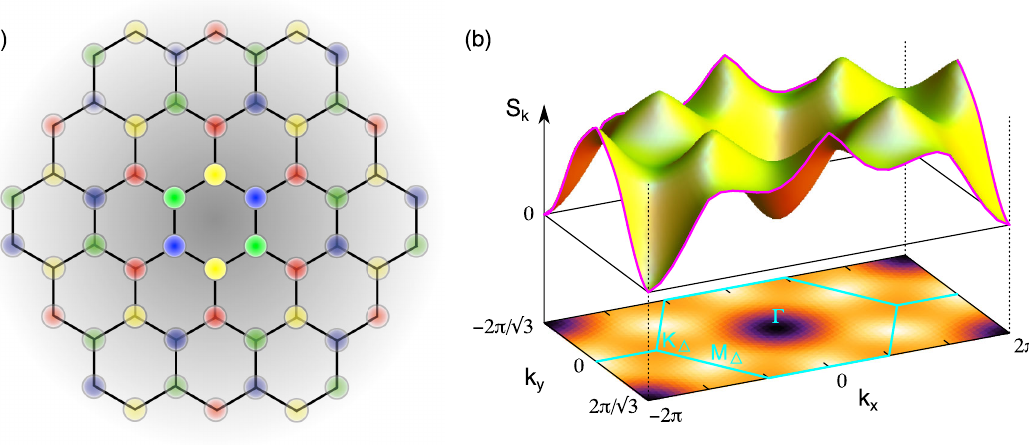
FIG. 1. Summary of the main properties of the spin-orbital liquid of the SU ð 4 Þ model on the honeycomb lattice. (a) Sketch of local color order. (The fading of colors illustrates the absence of long-range color order.) This pattern is the only one that respects the sequence of four colors along all the zigzag chains, whatever their orientation (horizontal, (cid:1)= 3 , or 2 (cid:1)= 3 ). (b) Color-structure factor of the Gutzwiller projected (cid:1) -flux state (VMC). The singular conical peaks are typical of algebraic